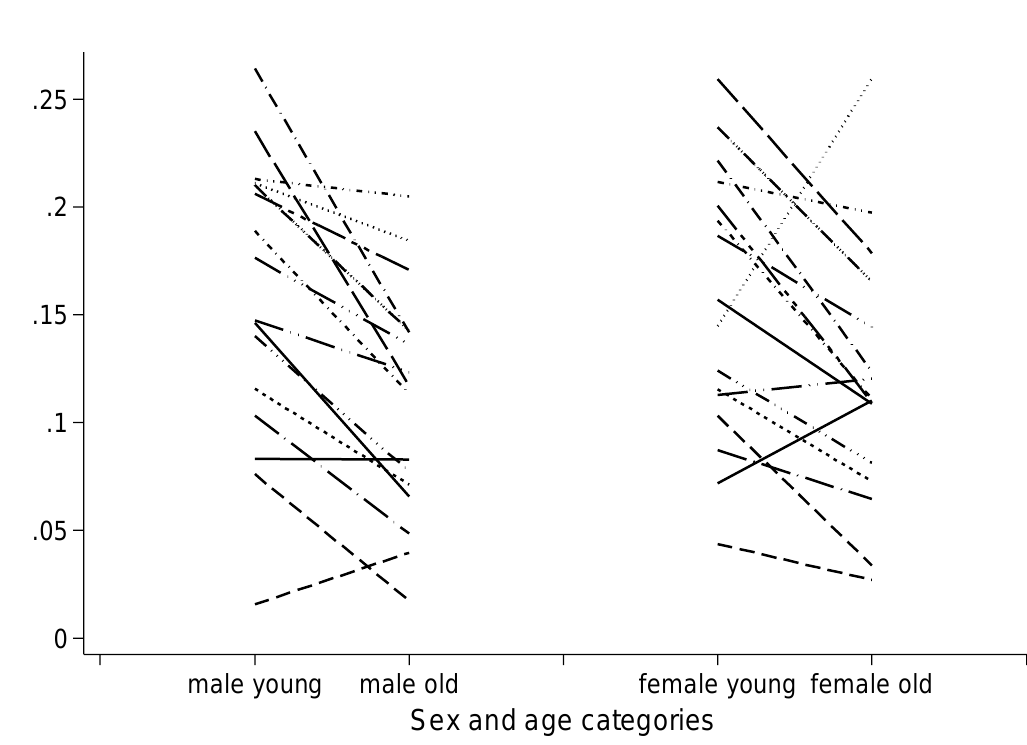
Figure 1: Mean decrement in EQ-5D-3L index score by sex and age for 17 common chronic